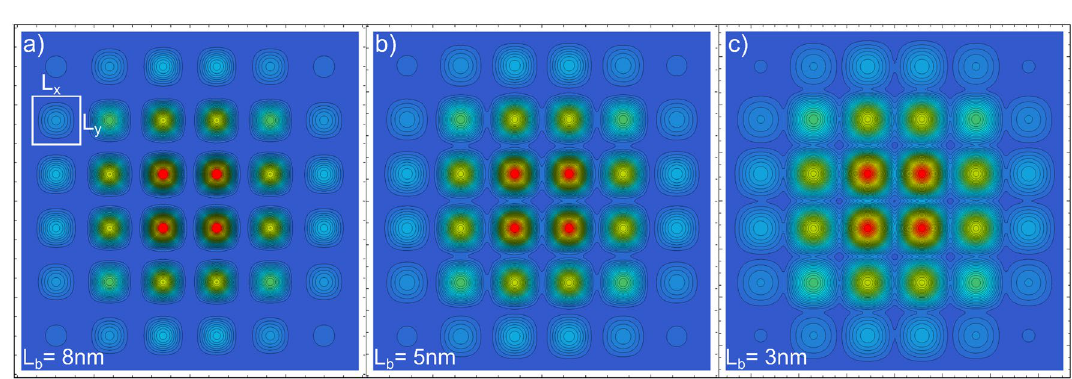
6 PNW arrays of L x , y = 20 nm. ×